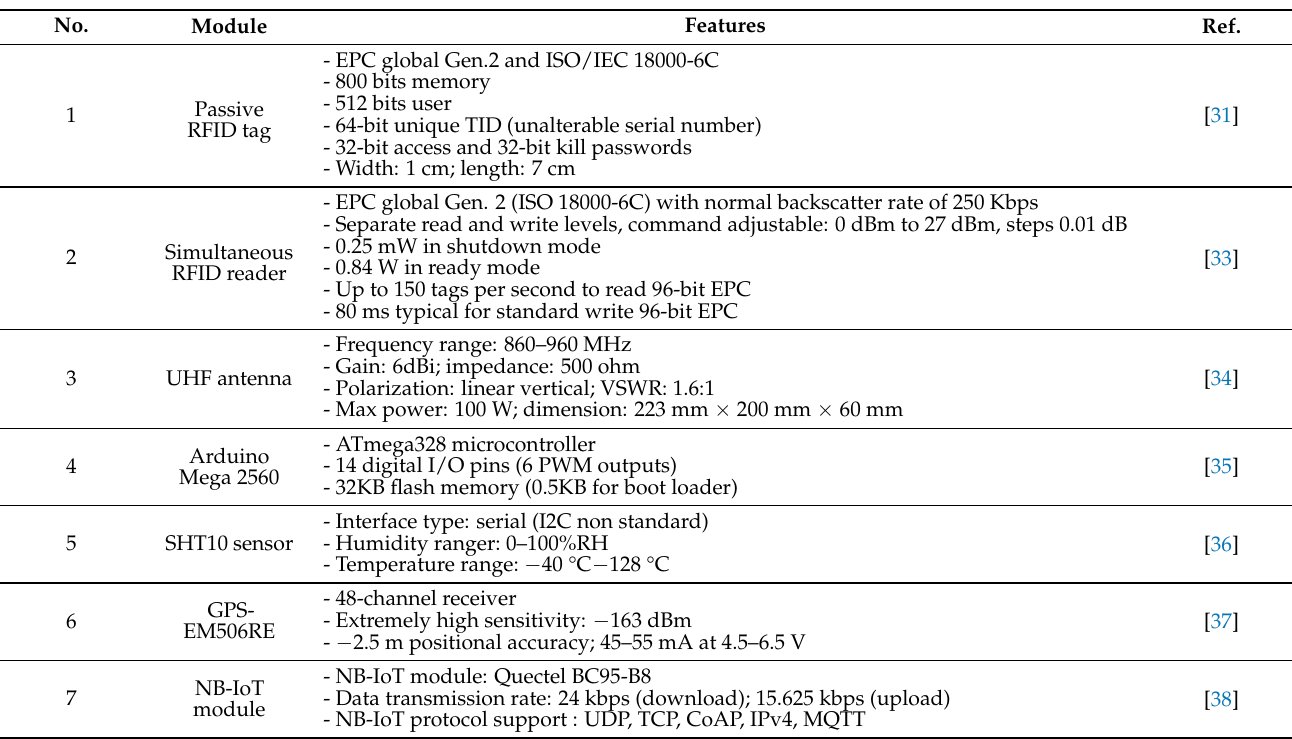
Figure 4. Components of specimen transport box. The box, commonly used at the Department of Lab- oratory Medicine, King Chulalongkorn Memorial Hospital, is from styrofoam, with a 5 cm thickness. Table 1. Modules